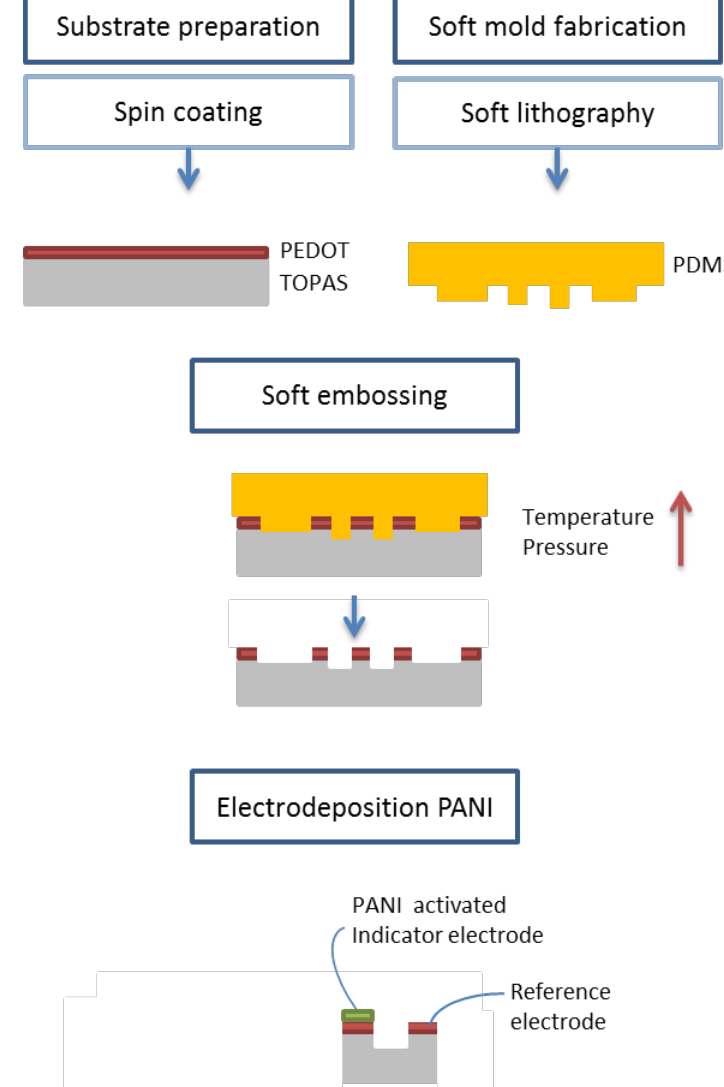
Figure 1. Scheme of the fabrication process.